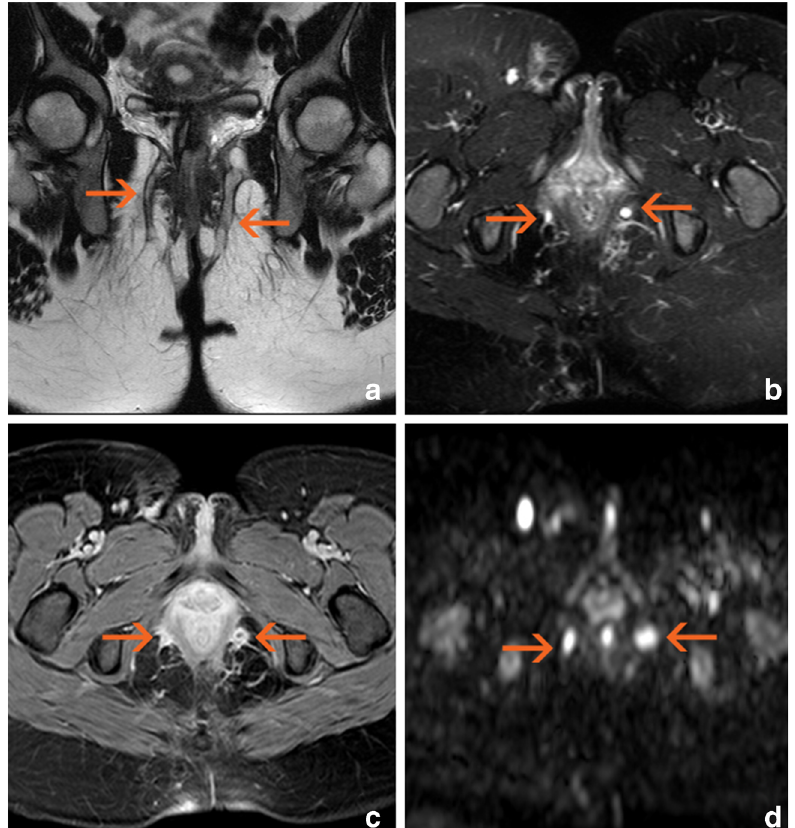
Fig. 1 Complex bilateral transsphinteric fistula cursing across both ischioanal fossae (arrows). a Oblique-coronal T2- weighted image. b Oblique- transverse fat-supressed T2- weighted image. c Post- gadolinium oblique-transverse fat-supressed gradient echo T1- weighted image. d Native oblique-transverse native diffusion-weighted image with 800 s/mm 2 b